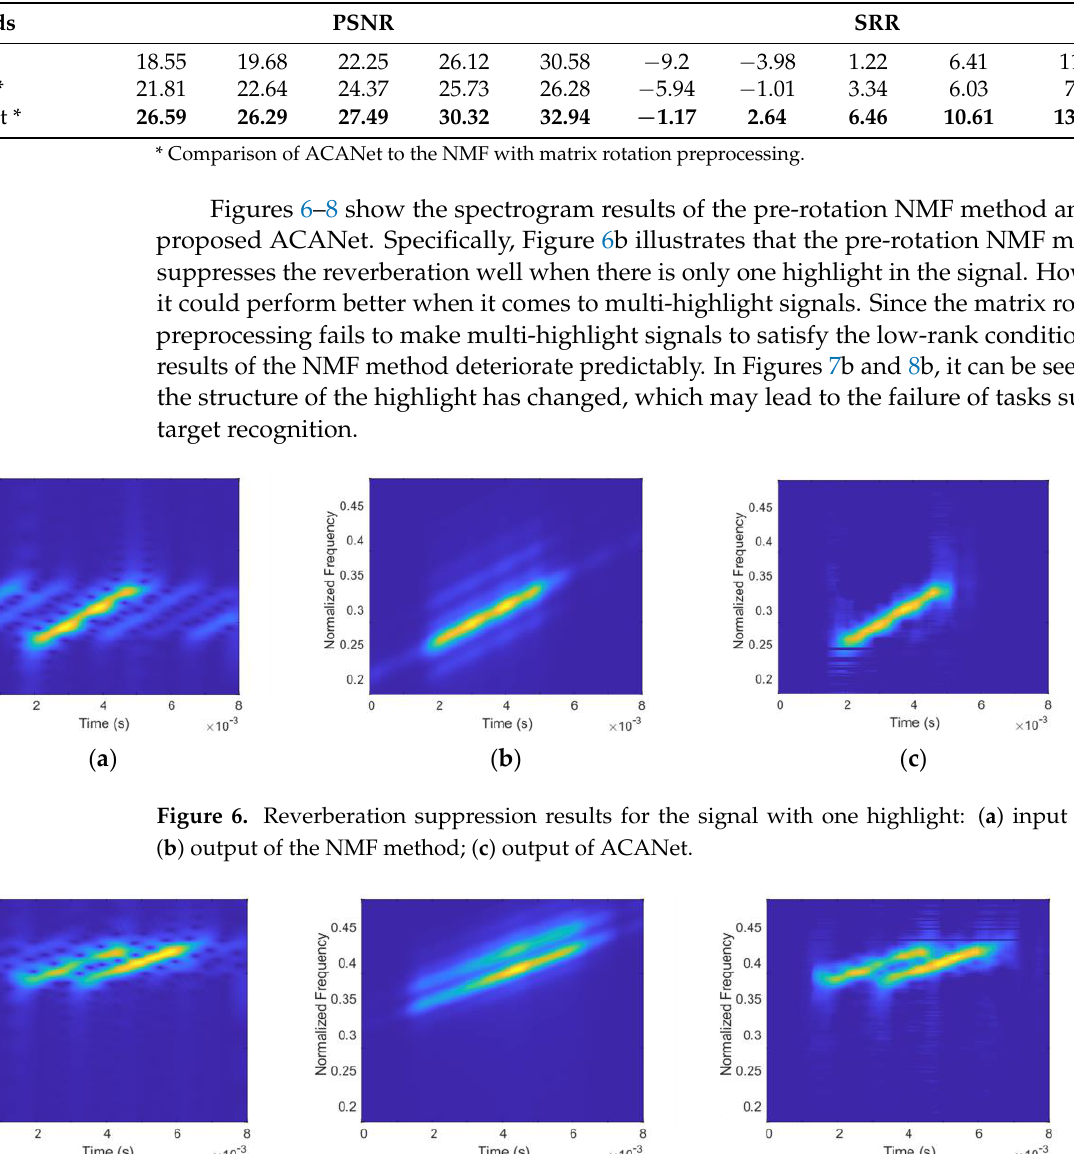
( c ) Figure 8. Reverberation suppression results for the signal with three highlights: ( a ) input signal; ( b ) output of the NMF method; ( c ) output of ACANet. 5. Conclusions and Future Scope Reverberation is the primary background interference for active sonar systems. Therefore, reverberation suppression is a crucial issue in underwater active sonar detec- tion tasks. To improve the reverberation suppression performance for most underwater targets, which usually contain multiple highlights, the ACANet with a multi-head self- attention module and a cepstrum analysis module is proposed. Systematic evaluations demonstrate that due to the rich cepstrum features provided by CAM, the dynamic fea- tures and robustness provided by SAM, and the larger receptive field provided by CM, the proposed ACANet is very effective at reverberation suppression in active sonar ob- served signals. On the one hand, the ACANet performs better than NMF methods in sup- pressing reverberation in single-highlight observed signals, with about 5 dB improvement in PSNR evaluation. On the other hand, when processing multi-highlight input signals that destroy the signal ’ s low-rank feature, it is difficult for NMF methods to separate